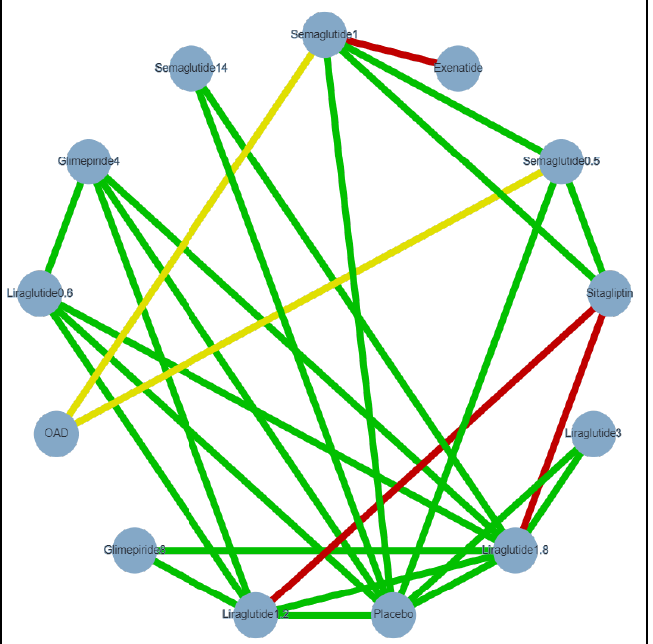
Figure 2. Evidence network of included studies for HbA1c analysis. Semaglutide 1 = Semaglutide 1 mg once-weekly (QW), Semaglutide 0.5 = Semaglutide 0.5 mg QW, Semaglutide 14 = oral semag- lutide 14 mg, Glimpiride 4 = Glimepiride 4 mg, Glimpiride 8 = Glimepiride 8 mg, Liraglutide 0.6= Liraglutide 0.6 mg once-daily (OD), Liraglutide 1.2 = Liraglutide 1.2 mg OD, Liraglutide 1.8 = Lirag- lutide 1.8 mg OD, Liraglutide 3 = Liraglutide 3 mg OD, OAD = Oral anti-diabetic drugs, Exenatide = Exenatide 2 mg, Sitagliptin = Sitagliptin 100 mg, HbA1c = glycated hemoglobin, Green: Low risk of bias, Yellow: Unclear risk of bias, Red: High risk of bias.